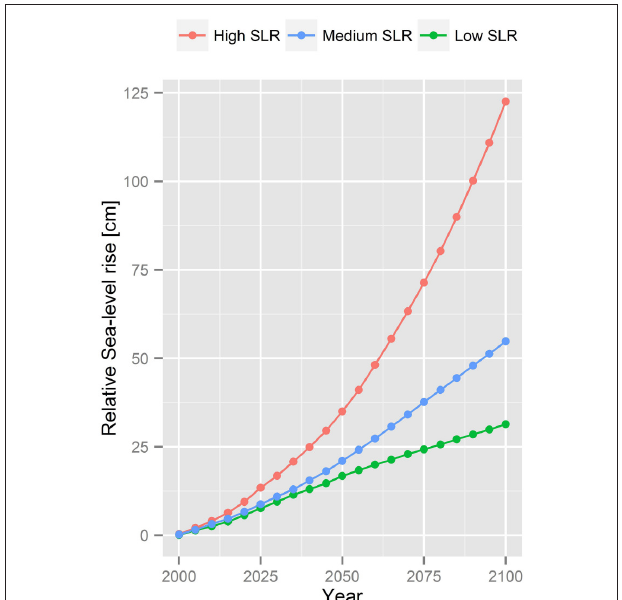
FIGURE 2 | The average relative sea-level rise for Emilia-Romagna under all sea-level rise